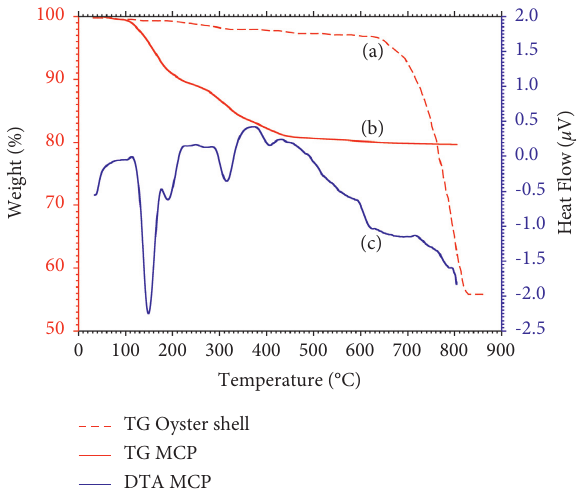
Figure 2: The thermogravimetric analysis (TG, red) and differ- ential thermal analysis (DTA, blue) for the oyster shell (dotted curve, (a)) and the synthesized product (solid curve, (b) and